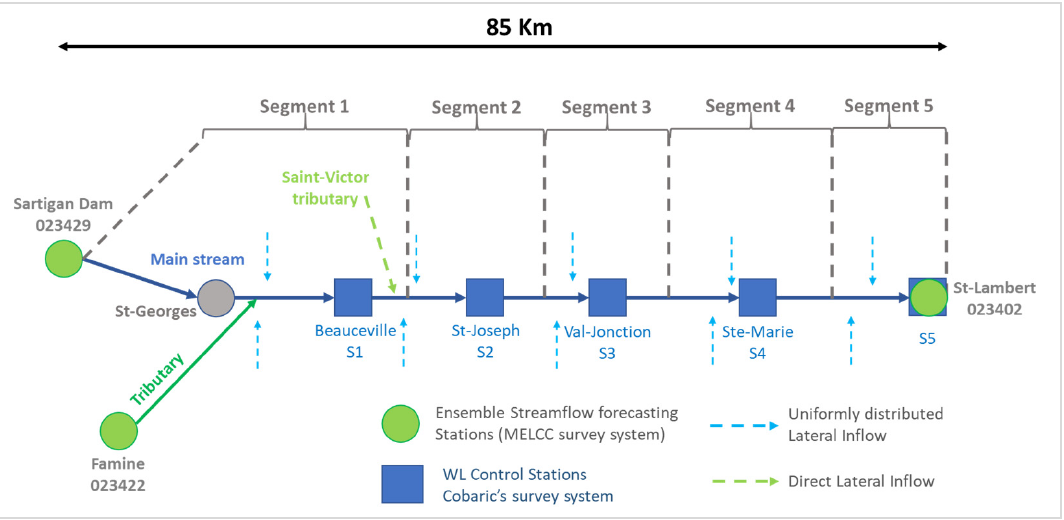
Figure 2. Simplified configuration of the Chaudière River model.